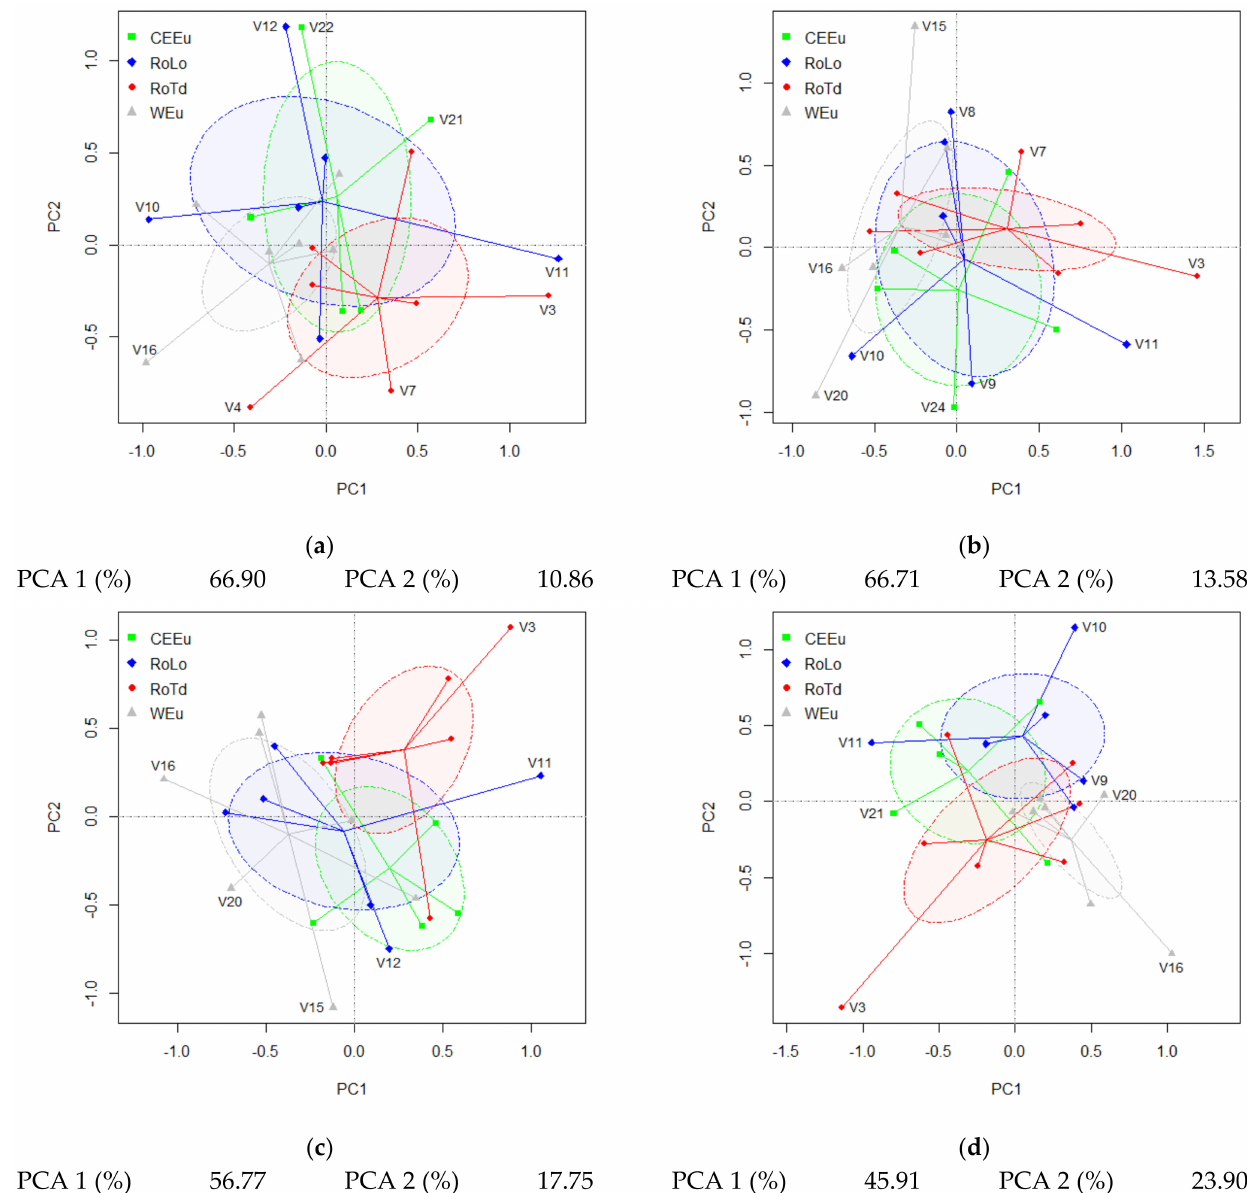
Figure 3. PCA of the source influence on spring oat in the interaction sowing density x fertilization within yield stability. Each point comprises the recorded values of yield in all of the three experimental years for each combination of Density x Fertilization: AF1 ( a ); AF2 ( b ); BF1 ( c ); BF2 ( d ). Density of sowing: A = 12.5 cm; B = 25.0 cm. Fertilization: F1 = N 100 P 50 ; F1 = N 50 P 50 . Separation of data in PCA graph is based on the source. Explained variance (%) is provide separately for each PCA axis. Ellipses represent the standard error within each group in a confidence interval of 95%. V1—Some¸san; V2–Mure¸s; V3–Mure¸sana; V4–T. 90-81 M; V5–T. 21-81 M; V6–T. 38-81 M; V7–T. 44-81 M; V8–LV. 4324-86; V9–LV. 4325-86; V10–LV.